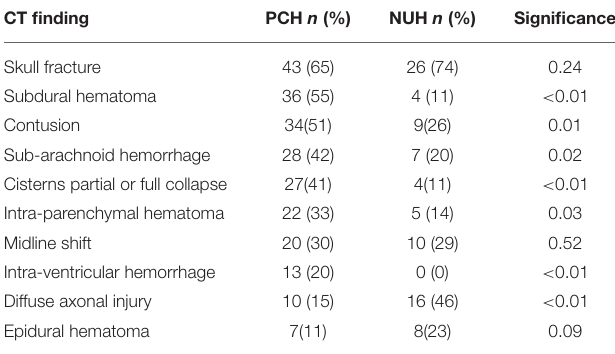
TABLE 2 | Time from injury to arrival by patient origin.